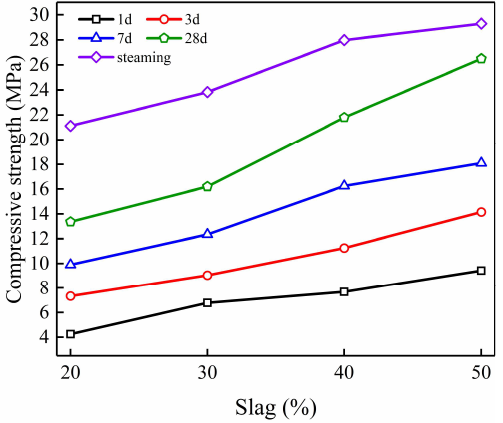
Figure 10. Effect of slag content on compressive strength.